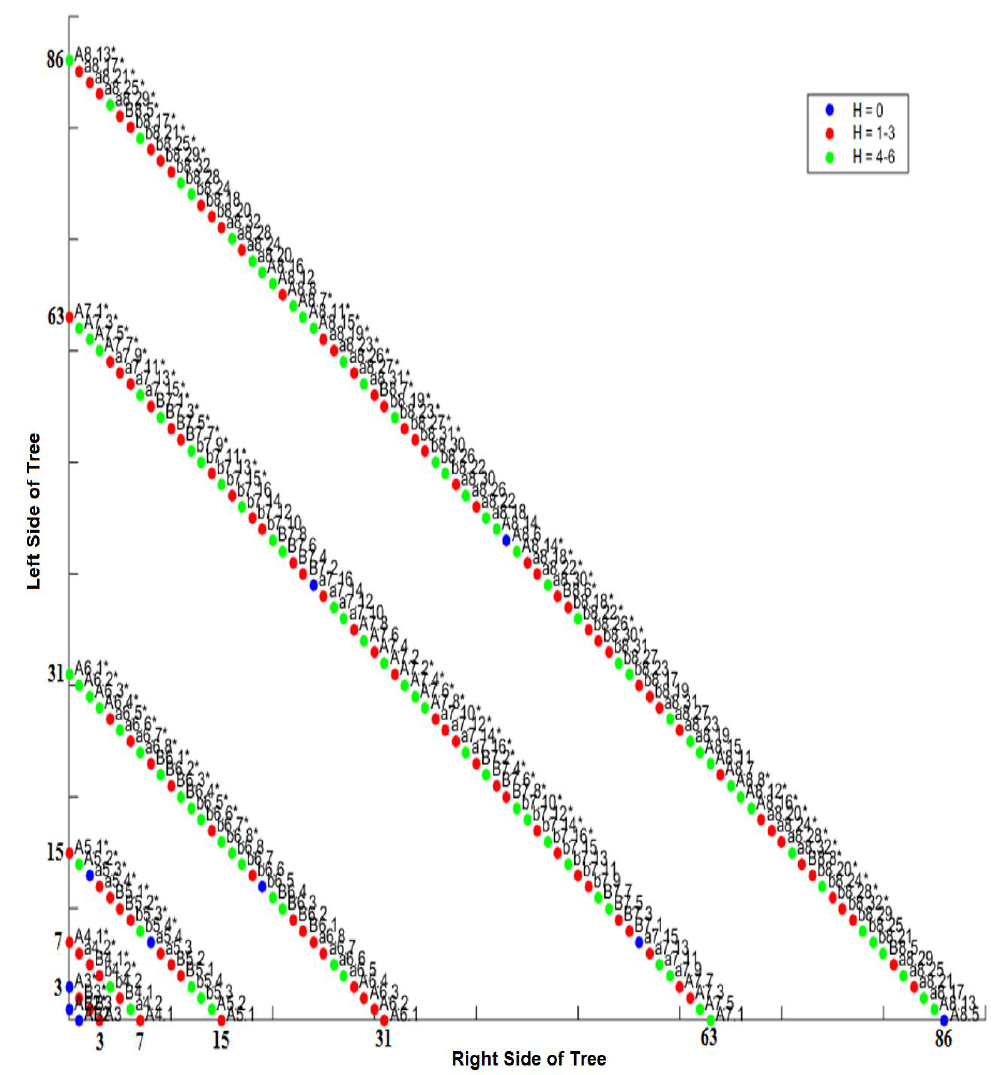
Figure 11. An isometric graph showing the Hamming distance of the differentiation tree from the lineage tree in Ciona (N = 213). The H abbreviation stands for Hamming distance. The position of a point representing a cell is based on the depth of its node in the differentiation tree. The positions of all points are rotated 45 degrees clockwise from a bottom-to-top differentiation tree ordering (where the 1-cell stage is at the bottom of the graph). Each cell is colored with its Hamming distance. Along a given line, the cells appear in their order, left to right, in the differentiation tree. For example, cells A.5.1 and A.5.1* at depth 4, where the total number of cells is 16 (ranging from 0 to 15), means cell A.5.1 is at the extreme left side of the differentiation tree, and cell A.5.1* is at the extreme right side of the differentiation tree. The other cells are spaced in between. The pattern of Hamming distances suggests that the relationship between the two orderings is nonrandom and therefore has some underlying anatomical